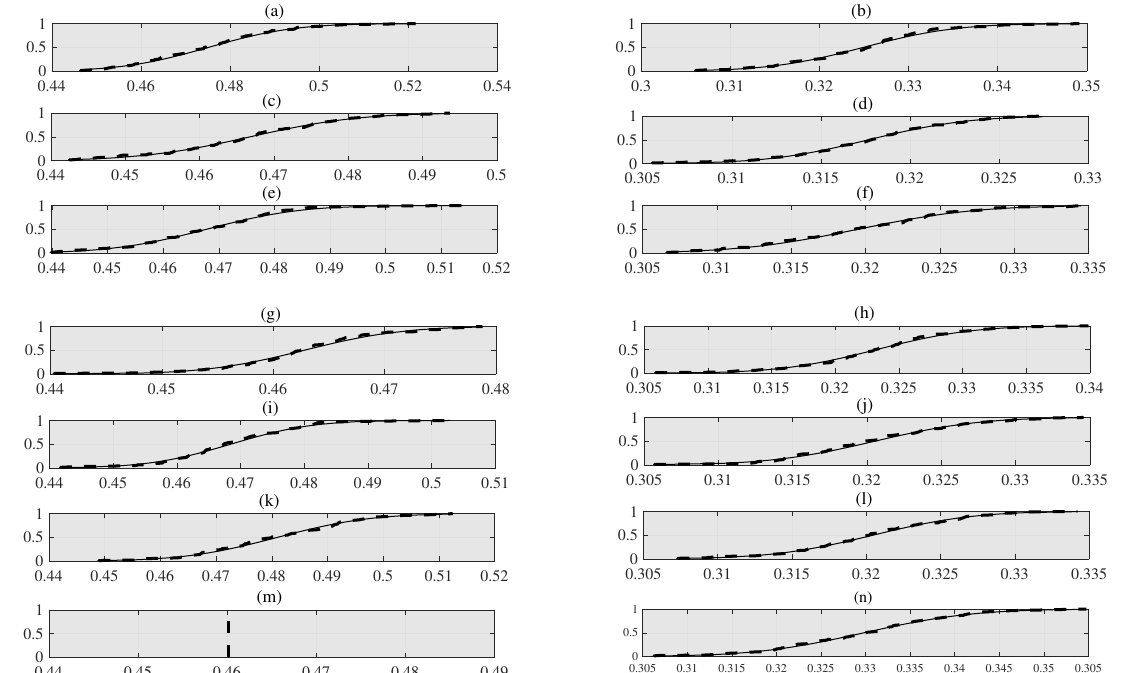
Figure 2. The CDF (cumulative distribution function) plots of artificial features ( a ) MAP (mean arterial pressure); ( b ) AR; ( c ) AE; ( d ) LE; ( e ) MA; ( f ) σ 1; ( g ) σ 2; ( h ) LMAP; ( i ) AR2; ( j ) AR3; ( k ) AE2; ( l ) AE3; ( m ) gender; ( n ) HR; and the subject’s age are investigated as the features and generated using the bootstrap technique with replication numbers ( B = 100) from one volunteer